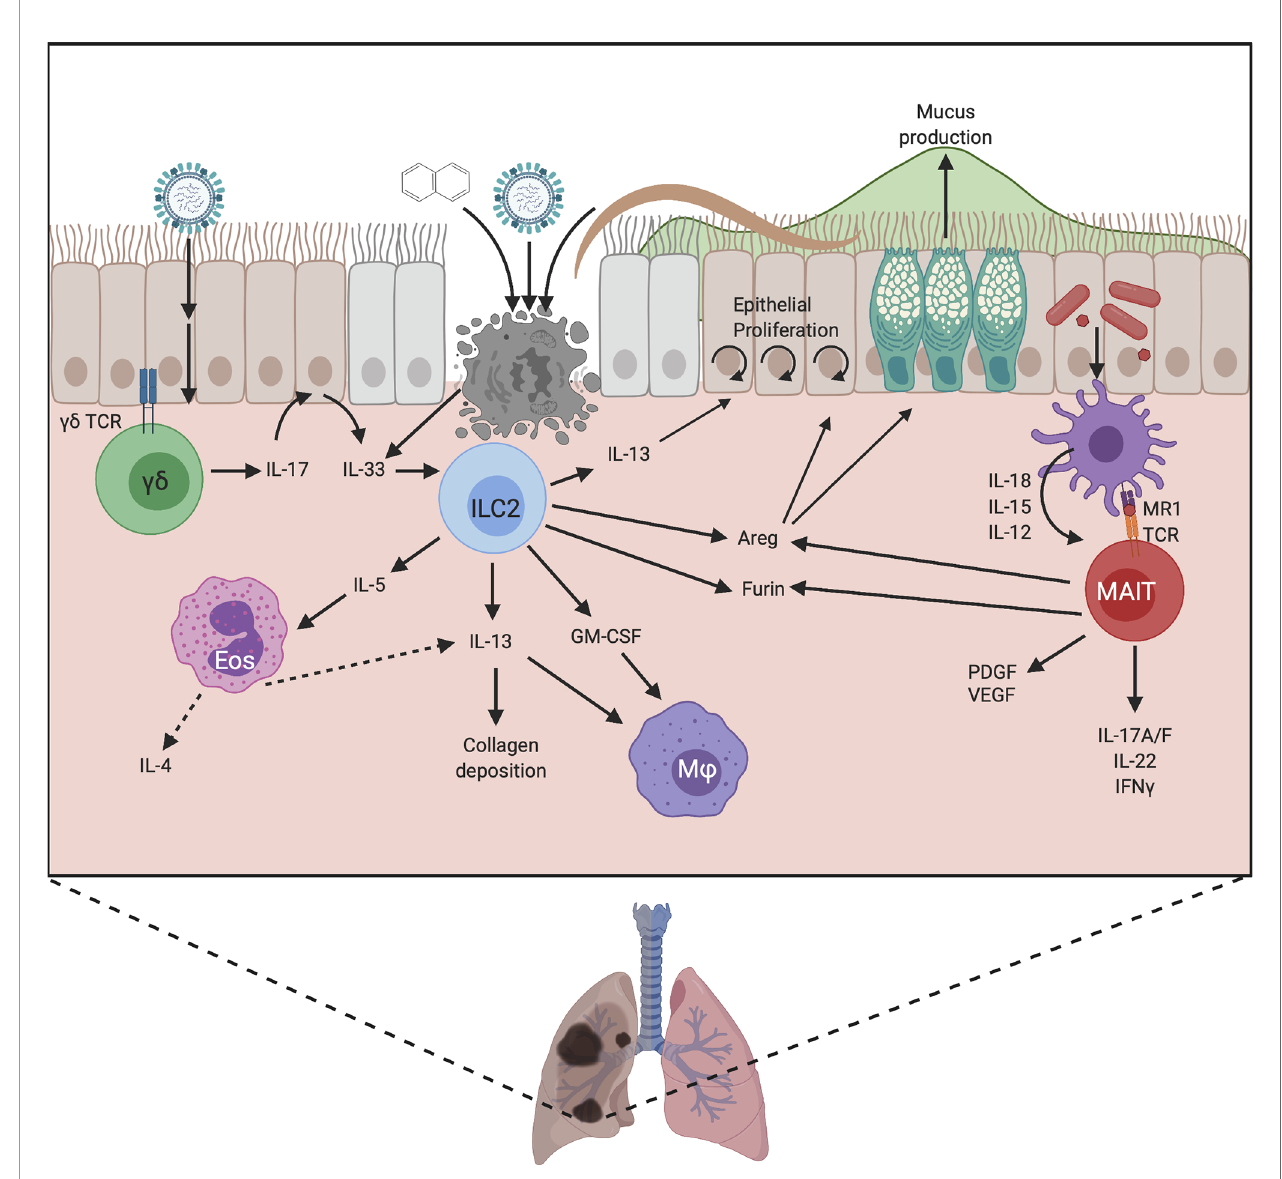
FIGURE 3 | Proposed mechanisms by which unconventional lymphocytes promote lung repair. Damage can be induced by chemical exposure or infection with viruses or helminths, which leads to IL-33 release by damaged epithelium. This activates ILC2, stimulating the production of cytokines and Areg. Areg promotes epithelial cell proliferation, reepithelialisation, and goblet cell activity, strengthening the mucus barrier. The production of IL-13 and GM-CSF by ILC2 recruits macrophages and promotes their alternative activation, allowing them to contribute to repair. IL-13 also promotes epithelial cell differentiation and proliferation, and modulates collagen deposition. ILC2s also produce IL-5 which recruits eosinophils. These eosinophils can produce IL-4 and IL-13 and may therefore also contribute to healing. ILC2s may contribute to repair by upregulating Furin to promote the activation of MMPs and TGF b , and they may directly regulate the extracellular matrix, but these mechanisms are yet to be proven. In neonatal lung gd T cells respond to infection by producing IL-17 which stimulates IL-33 release by epithelial cells. Lung MAIT cells can become activated by TCR ligands from microbes, and cytokine signals from damaged cells, leading to the production of IFN g , IL-17A/F and IL- 22 which can promote epithelial proliferation. MAIT cells can also produce growth factors such as PDGF and VEGF which play a role in repair. Similar to ILC2s, MAIT cells can produce Areg which promotes epithelial cell turnover and goblet cell activity, and they may also upregulate furin to increase protein cleavage and activation. Created with